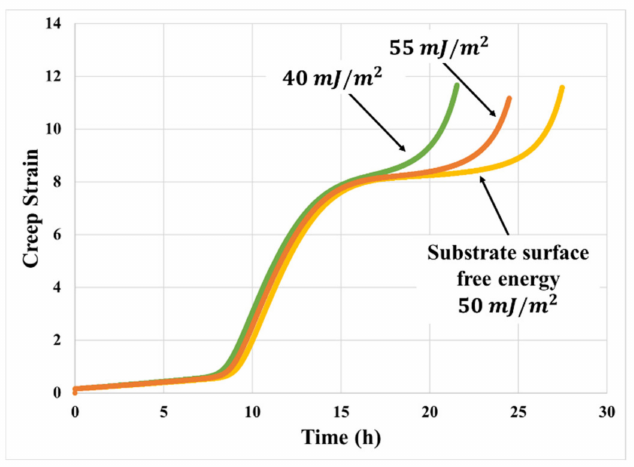
Figure 19. Effect of substrate surface free energy on creep model prediction (50 kPa, 70 ◦ C with PSA surface free energy of 30 mj/m 2 ).